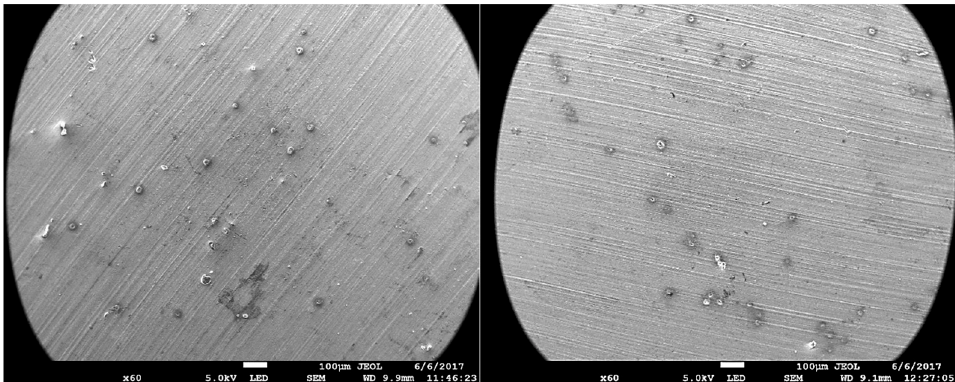
Figure 7. Scanning electron microscope image of aluminum samples before ( left ) and after ( right ) the treatment with an Ar-N 2 (1% N 2 ) postdischarge.